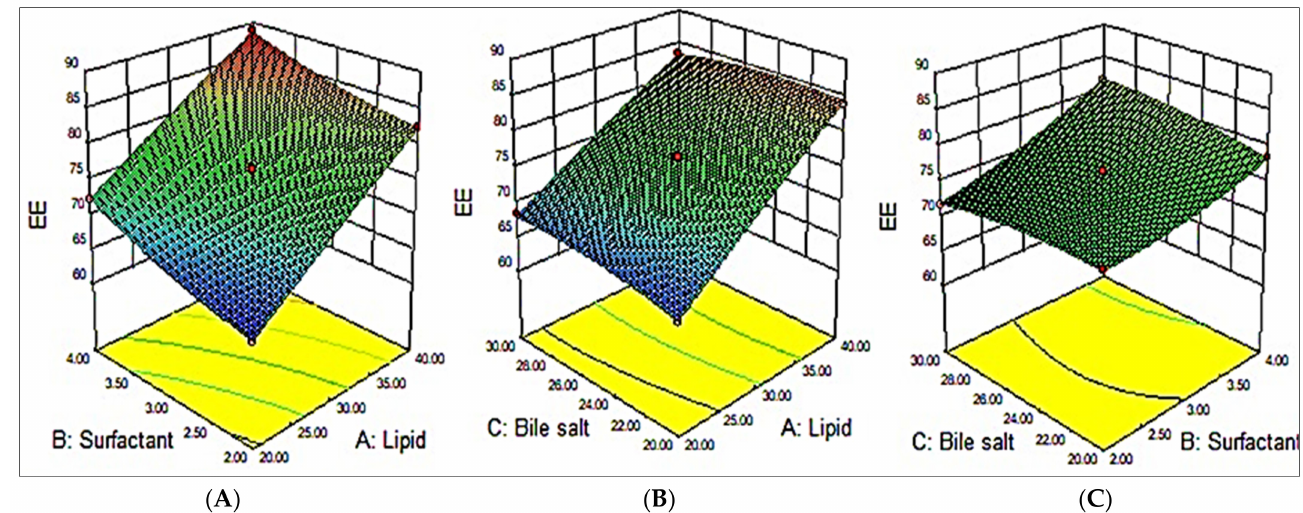
Figure 2. Effects of variables, namely, cholesterol ( A ), surfactant ( B ), and bile salt ( C ), on the depen- dent variable encapsulation efficiency (EE; Y 2 ).